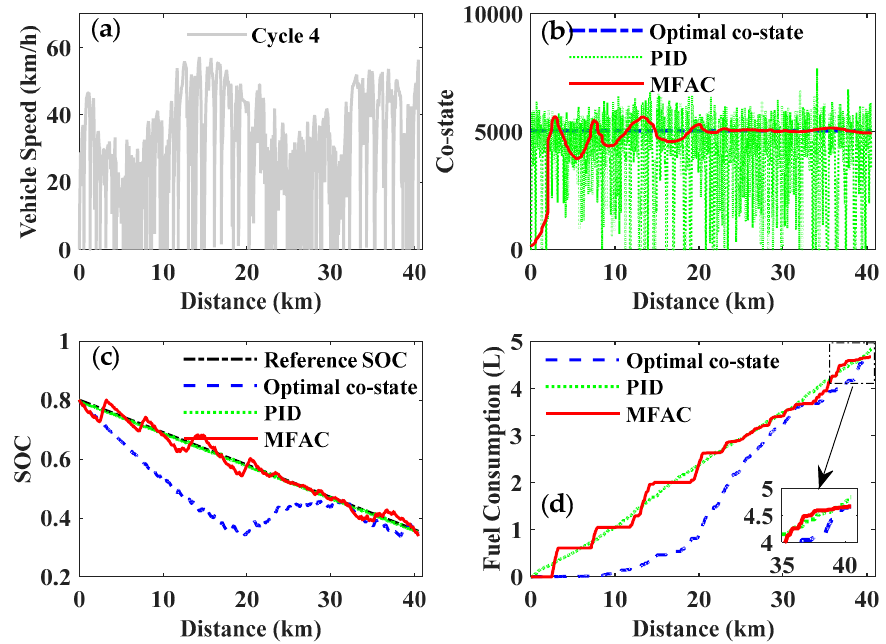
Figure 21. The simulation results of driving Cycle 4. ( a ) Driving cycle; ( b ) Co-state; ( c ) SOC; ( d ) Fuel consumption.